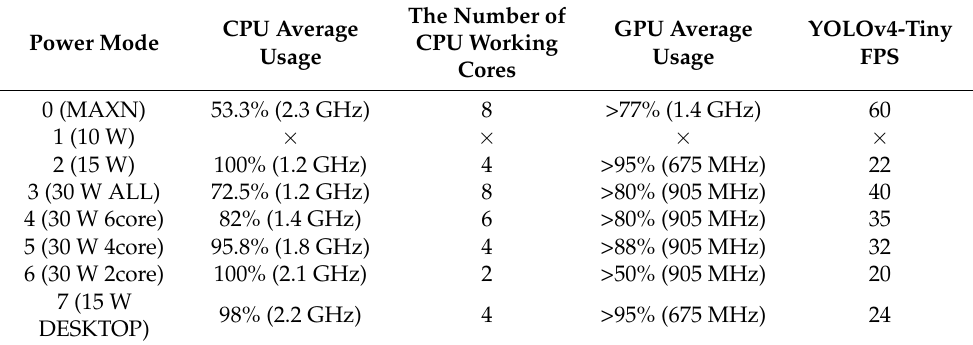
Table 3. Jetson AGX tests for each power mode.